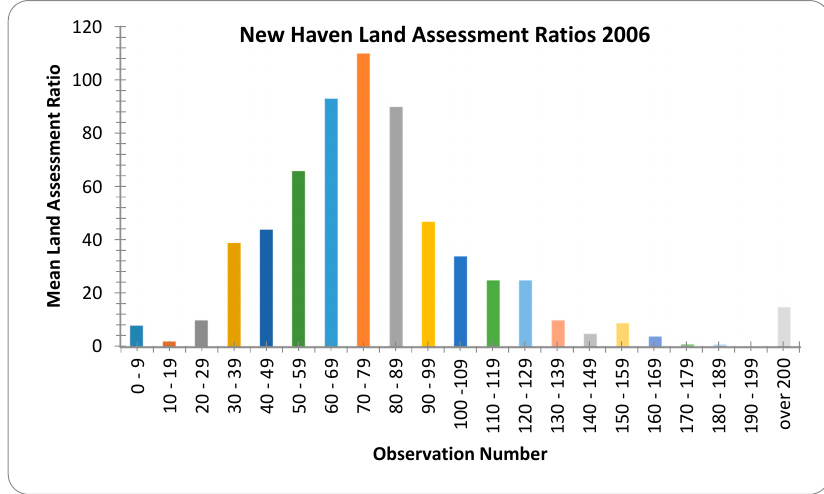
Figure 5. Land assessment ratios in New Haven for the tax year 2006. The observation number (horizontal axis) is a range, and the Mean Land Assessment Ratio (vertical axis) is the mean overall ratio in the corresponding range. For instance, 0–9 indicates observations 0 to 9; …; over 200 indicates observations 200 and over.